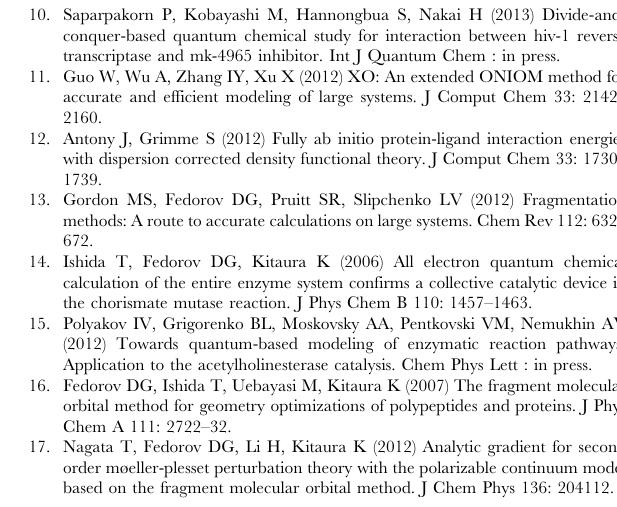
Figure S2 Two different starting geometries with chor- ismate and Phe57 shown as sticks from the MD simulation. A) shows a configuration which results in a successful reaction path and B) a configuration which results in an unsuccessful reaction path (see Figure S1). The position of Phe57 coupled with a placement in the buffer region ( b ) makes it unable to move to accommodate the conversion of chorismate to prephenate. Table S1 Complete listing of all residues in the protein model (PDB: 2CHT) along with their protonation state after being protonated using the PDB2PQR tool. (PDF) Table S2 Reaction barriers of chorismate mutase calculated using ONIOM for EFMO:S using R resdim ~ 1 : 5 and FD (modfd = 1). Table S3 Reaction barriers of chorismate mutase calculated using ONIOM for EFMO:S using R resdim ~ 2 : 0 and FDD (modfd =3). Table S4 Reaction barriers of chorismate mutase calculated using ONIOM for EFMO:L using R resdim ~ 1 : 5 and FDD (modfd =3). Table S5 Reaction barriers of chorismate mutase calculated using ONIOM for FMO2:S using R resdim ~ 1 : 5 and FDD (modfd